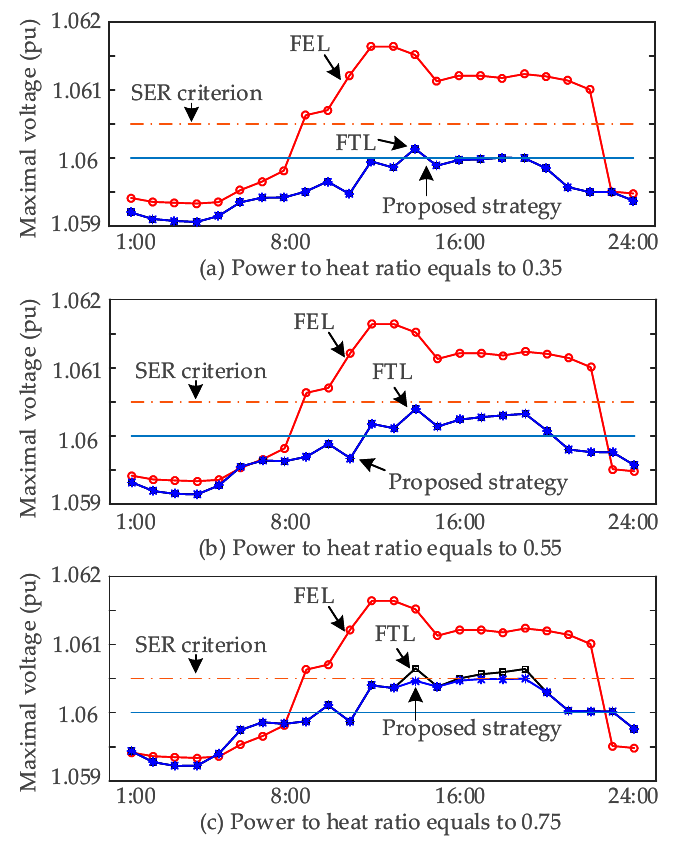
Figure 9. Maximal voltages under different control strategies in transition seasons (power to heat ratio of CHP generation is set with diverse value, where ( a ) C = 0.35; ( b ) C = 0.55; and ( c ) C = 0.75).